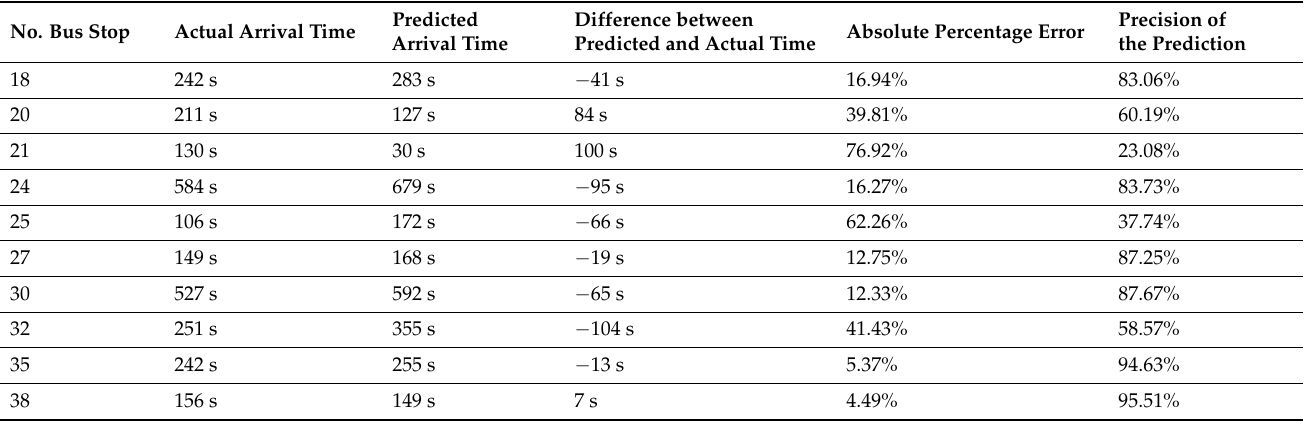
Results obtained for Trip 6, Journey: University–Guacamayas. MAE = ± 59.4 s, MAPE = 28.9% Precision =